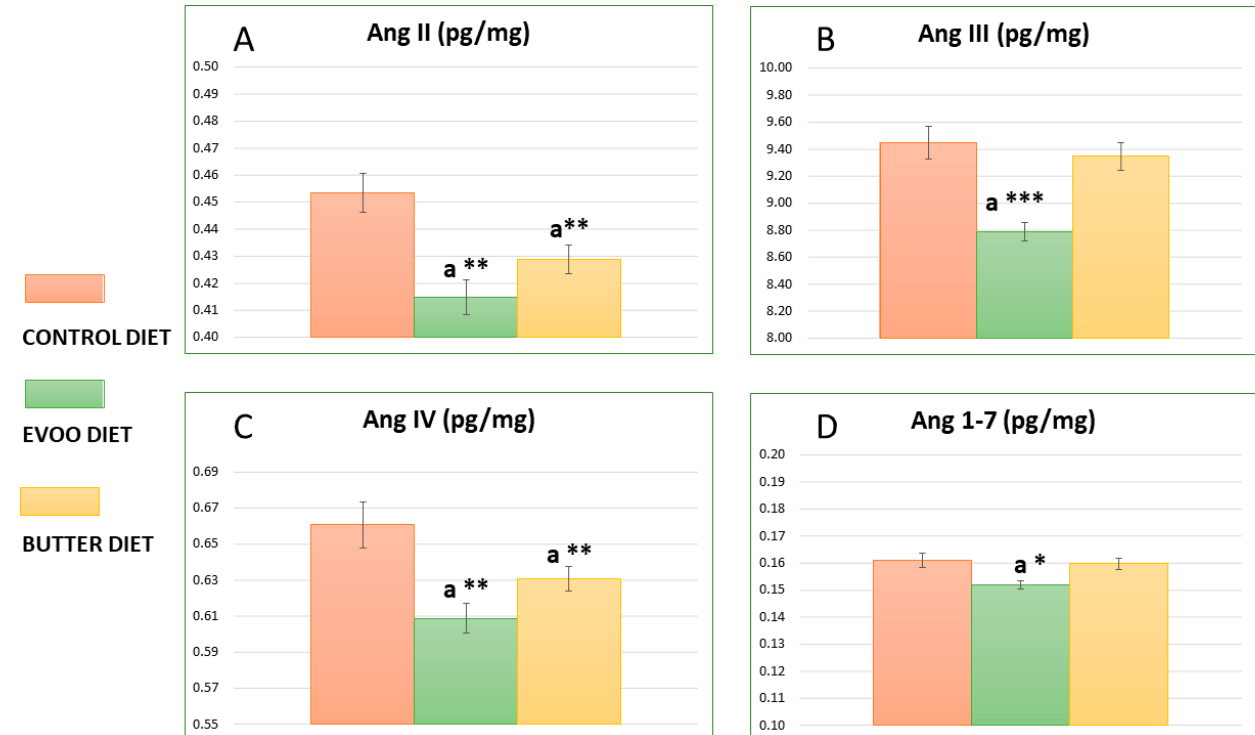
Figure 1. Means values ± SEMs obtained from the hypothalamus of experimental animals (the control, EVOO, and butter diets) for different angiotensin peptides (AngII ( A ), AngIII ( B ), AngIV ( C ), and Ang1–7 ( D )) expressed as pg/mg. a Significant differences between the EVOO, butter, and control diets. * p < 0.05, ** p < 0.01, and *** p < 0.001.